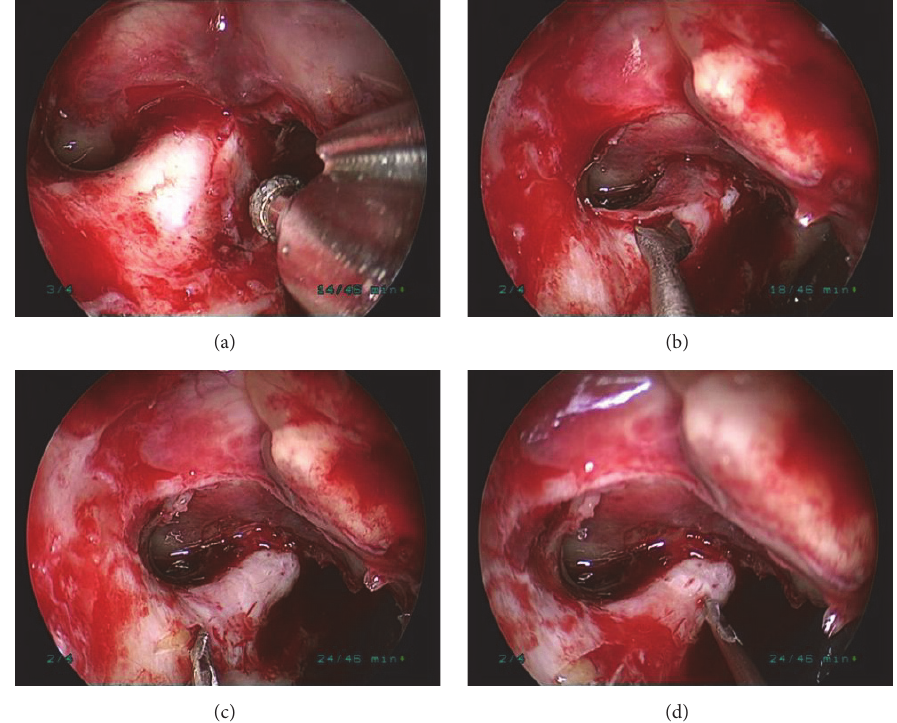
Figure 1: The surgical procedures of ETOCD. (a) The medical wall of optic canal was thinned by a microdrill. (b) The thinned medial wall of optic canal was removed by a microcurette. (c) The periorbita of the orbital apex and annulus of Zinn was split with a sharp 9# MVR knife. (d) Five to six small intermittent punctuated incisions were made to the optic nerve